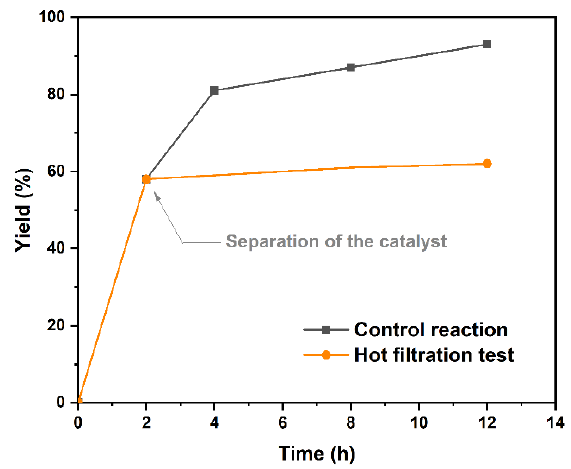
Figure 10. Hot filtration test in the azide-alkyne cycloaddition reaction catalyzed by Cu-Fe 3 O 4 -PAC.